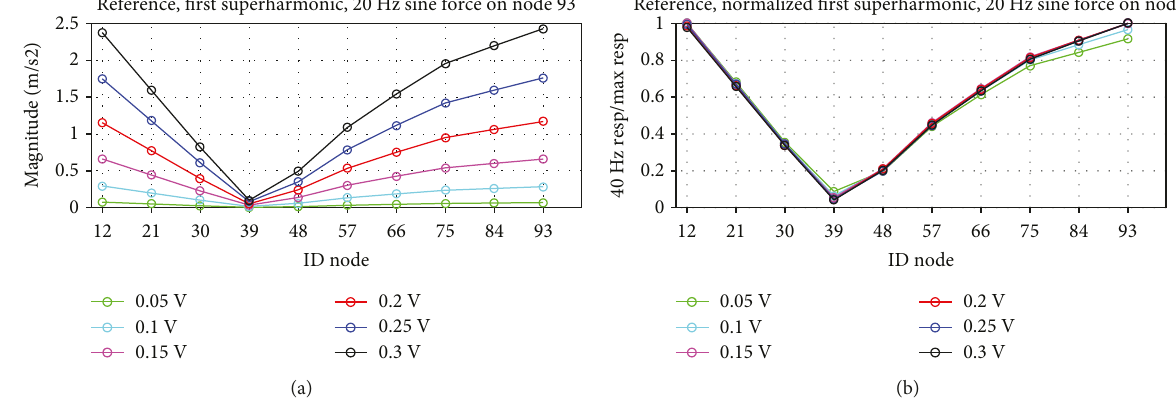
Figure 46: 40Hz FFT magnitudes, 20Hz sine excitation force applied to node 93, reference structure.